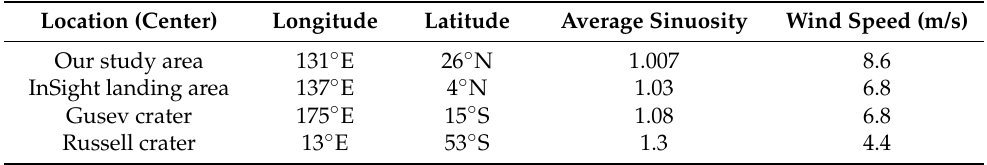
Table 2. The relationship between average sinuosity of DDTs and local wind speed. Location (Center)